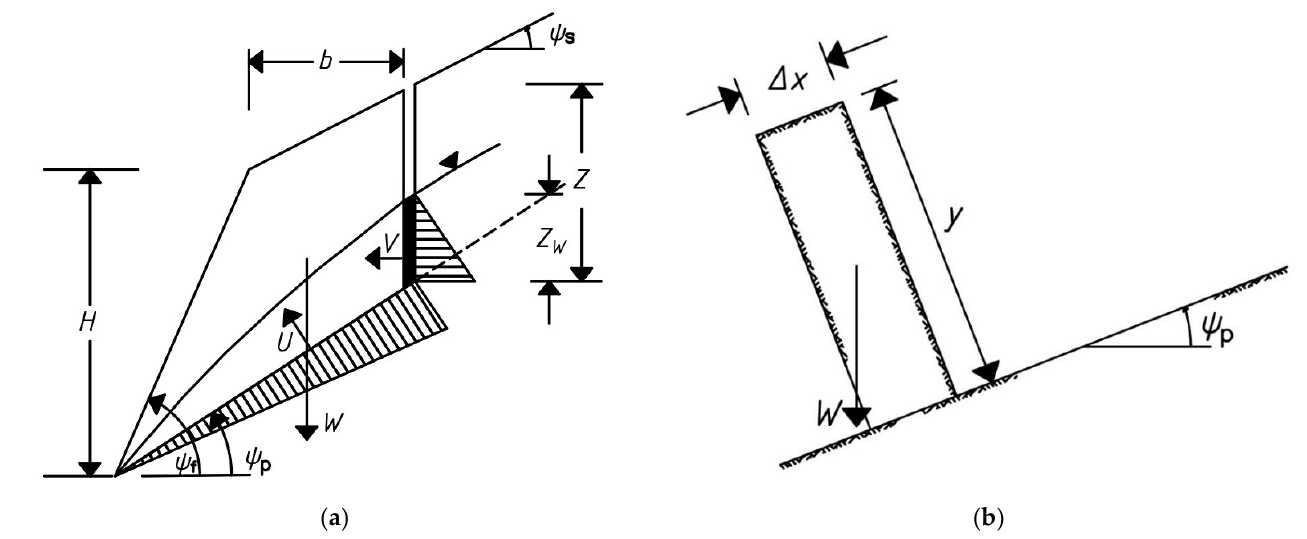
Figure 11. Geometrics and forces of ( a ) planar sliding failure; ( b ) direct toppling failure (Reprinted with permission [90] 2004, Spoon Press).